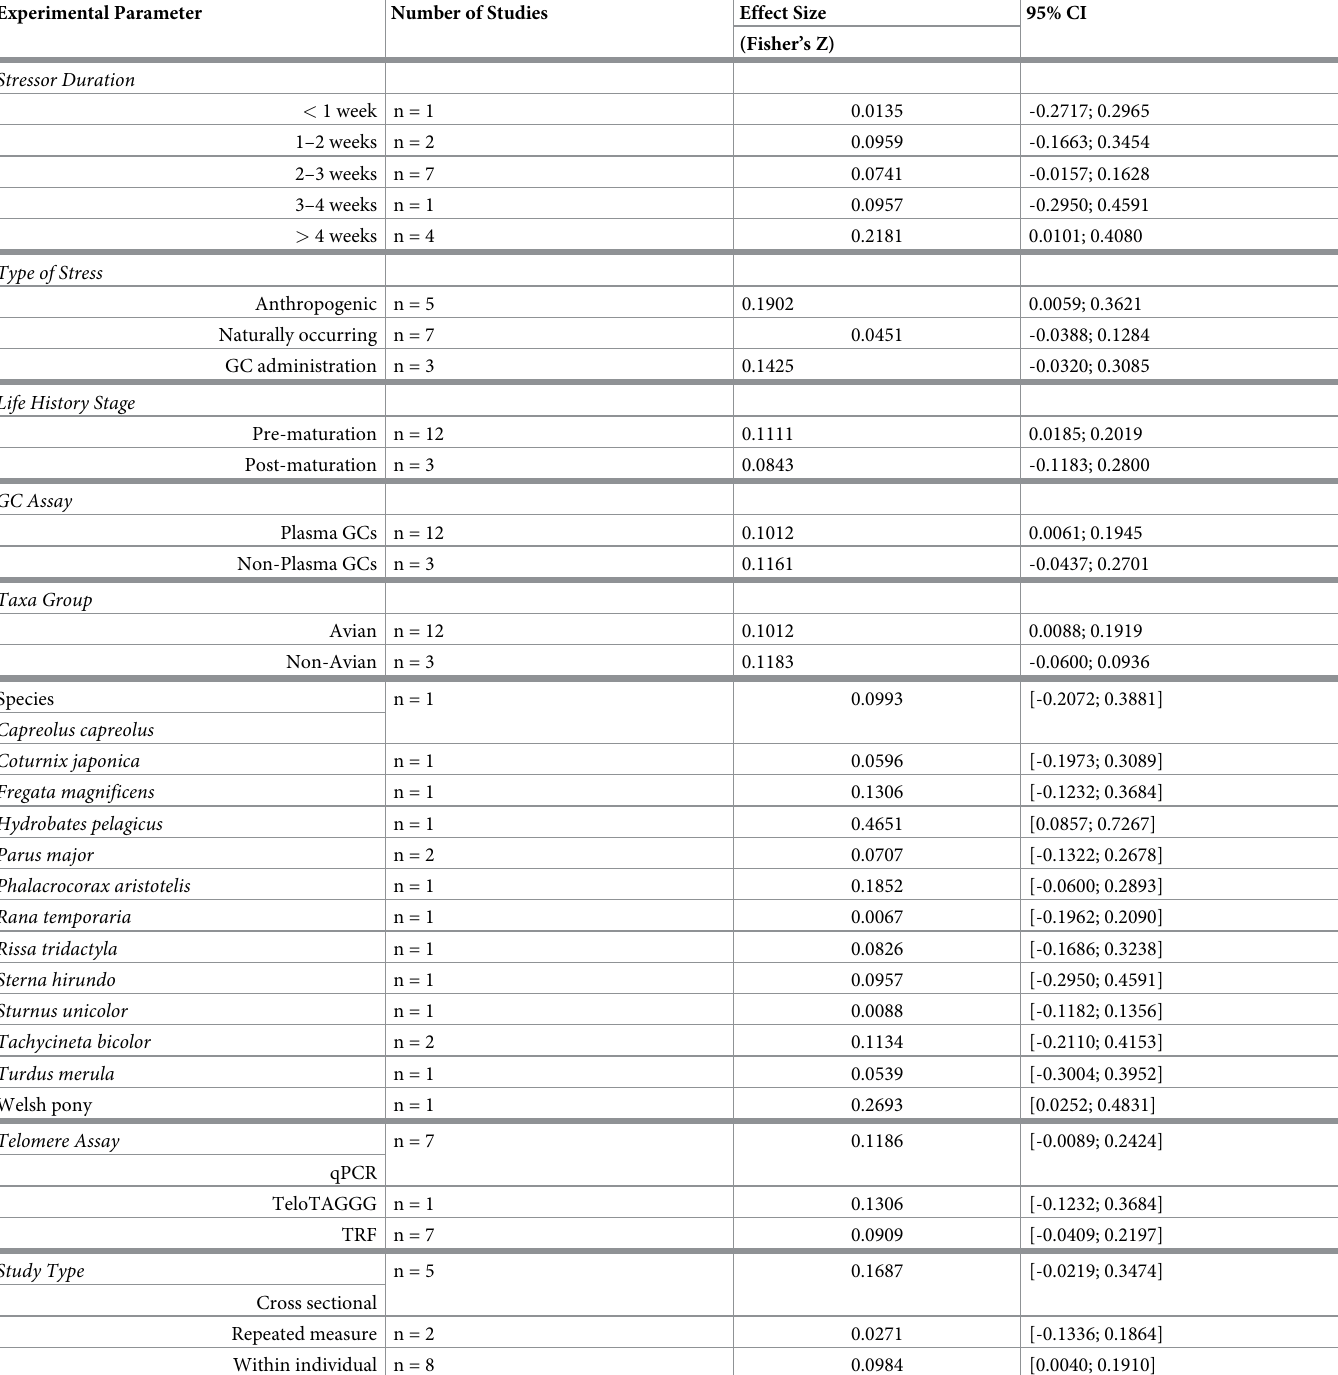
Table 1. Pooled effect sizes with 95% CI of experimental parameters investigated during the five subgroup analyses for stressor duration, stressor type, life history stage, GC assay and taxa